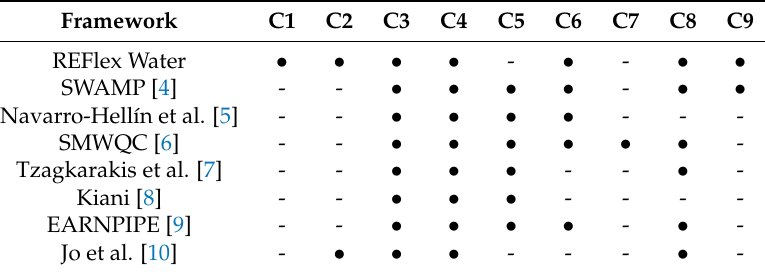
Table 1. Summary of comparison study between